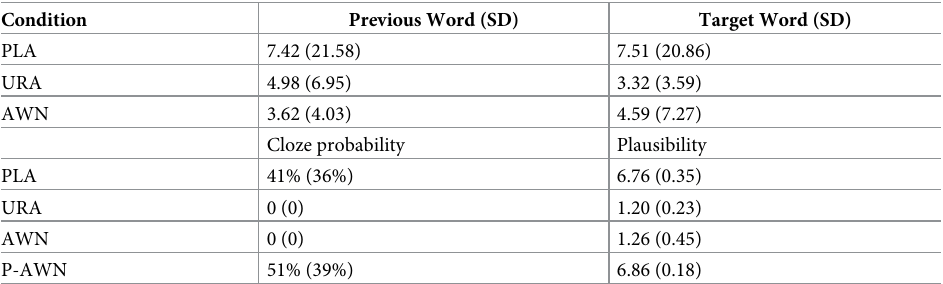
Table 1. Target word and pre-target word frequencies and sentence